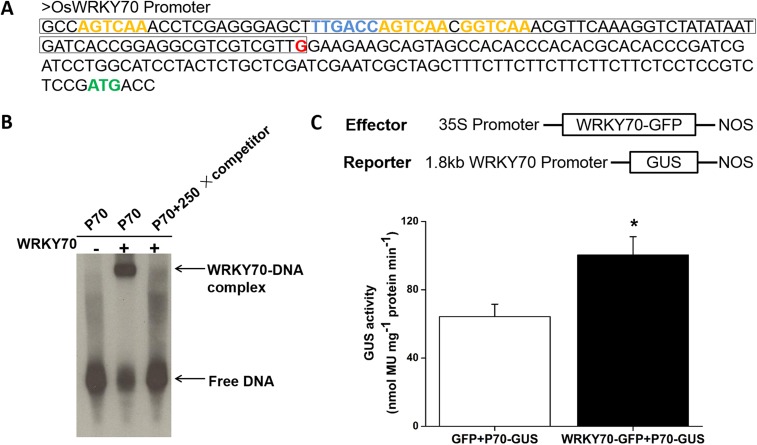
Self-activation of OsWRKY70.(A) Partial sequence of OsWRKY70 promoter. Green highlights represent the translation initiation sites. Red highlights represent the transcription start sites. Blue and orange highlights represent W-boxes in sense and antisense strands, respectively. The framed sequence was used for EMSA assay. (B) In vitro EMSA assay for the binding activity of WRKY70 to the minimal WRKY70 promoter (P70). Competition experiments were performed using unlabeled BS65 as a competitor in a 250-fold molar excess. (C) In vivo transient assay for transactivation activity of OsWRKY70. The WRKY70 promoter (1.8 kb):GUS and 35S:WRKY70-GFP were transiently expressed in N. benthamiana leaf cells. 2 days after infiltration, samples were harvested and GUS activities were quantified. 35S:GFP was used as a control. Eight plants were used for each treatment. Asterisks indicate significant differences in WRKY70-GFP-expressed plants compared with GFP controls (*, p < 0.05; Student's t-test).